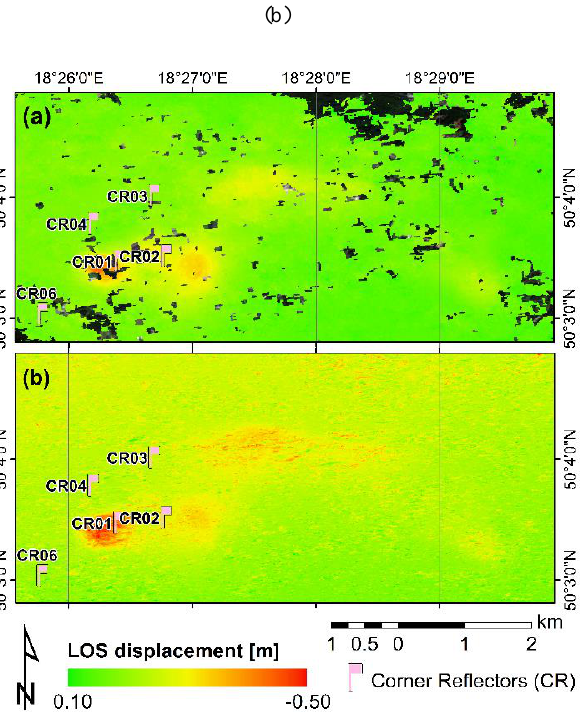
Figure 3. Cumulative deformation of the DInSAR descending orbit with relative number 51 (a) and with relative number 124